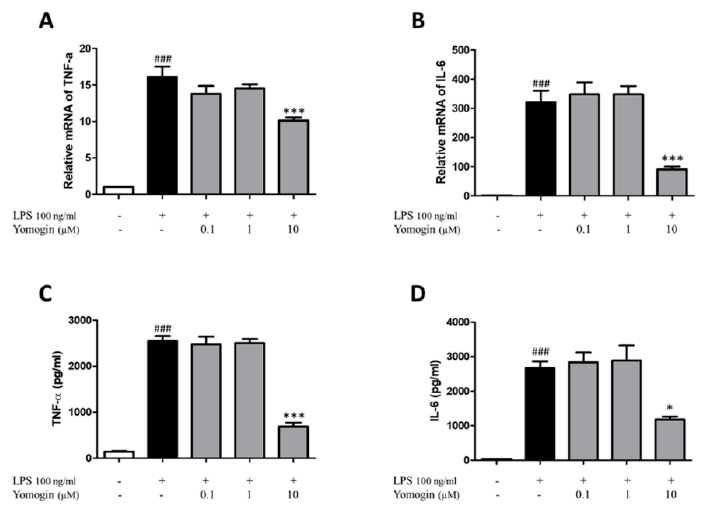
Figure 5. E ff ects of yomogin on secretion of TNF −α and IL − 6 in LPS-stimulated BV2 microglial cells. The cells were pre-treated various concentrations (0.1 − 10 µM) of yomogin for 1 h before LPS treat- cells. The cells were pre-treated various concentrations (0.1–10 µ M) of yomogin for 1 h before LPS ment. The mRNA levels of TNF −α ( A ) and IL − 6 ( B ) were measured by qRT − PCR ( n = 4). The levels treatment. The mRNA levels of TNF- α ( A ) and IL-6 ( B ) were measured by qRT-PCR ( n = 4). The of TNF −α ( C ) and IL − 6 ( D ) were analyzed in the supernatants by ELISA kit ( n = 4 per group). Data levels of TNF- α ( C ) and IL-6 ( D ) were analyzed in the supernatants by ELISA kit ( n = 4 per group). were analyzed by one − way ANOVA, followed by Tukey’s post hoc test. ### p < 0.001 compared to Data were analyzed by one-way ANOVA, followed by Tukey’s post hoc test. ### p < 0.001 compared the control group; * p < 0.05 and *** p < 0.001 compared to the LPS − only − treated group. Values are to the control group; * p < 0.05 and *** p < 0.001 compared to the LPS-only-treated group. Values are the mean ± SEM. the mean ±